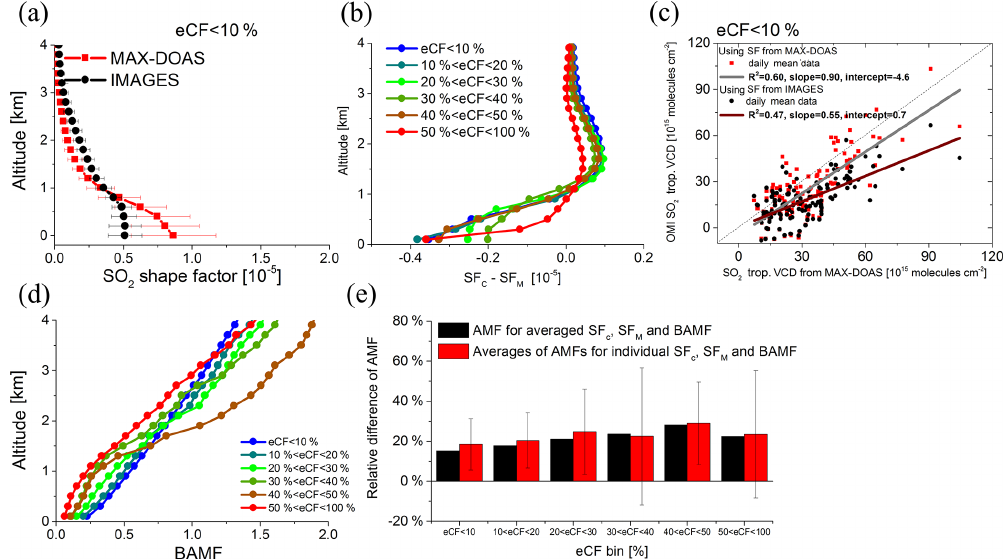
Figure 10. Similar to Fig. 9 but for the OMI BIRA SO 2 product. Note that the SF for the OMI BIRA product is obtained from the IMAGES